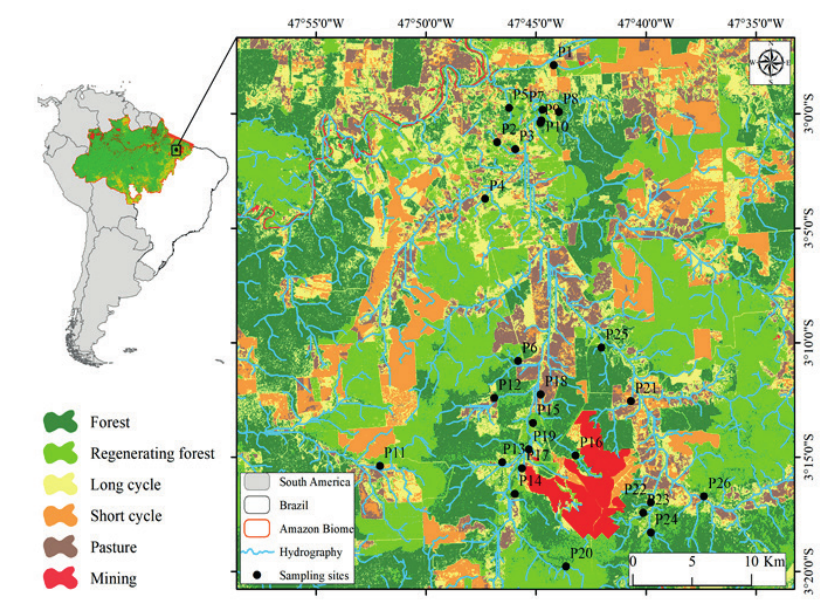
FIGURE 1 | Location of sampling streams (Middle Capim River basin, Pará State, Brazil). The characteristics of each land use class are described in the Material and Methods